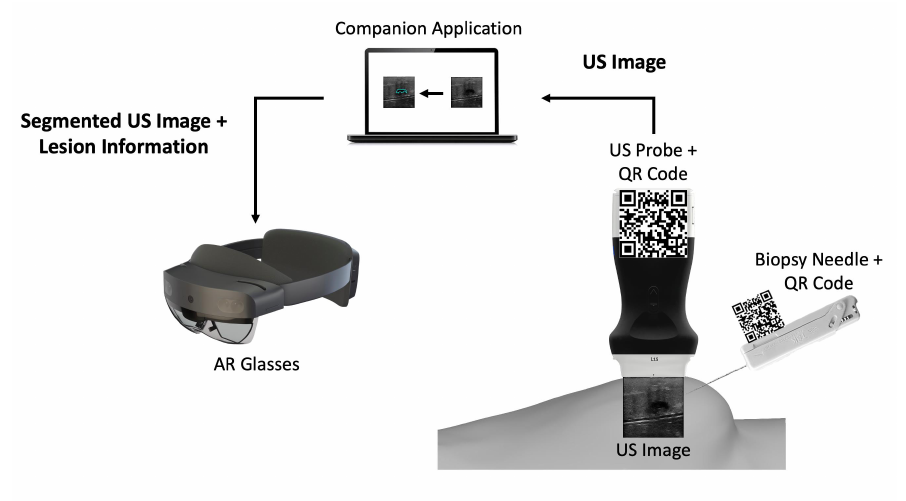
Figure 1. Overview of the different components of the proposed